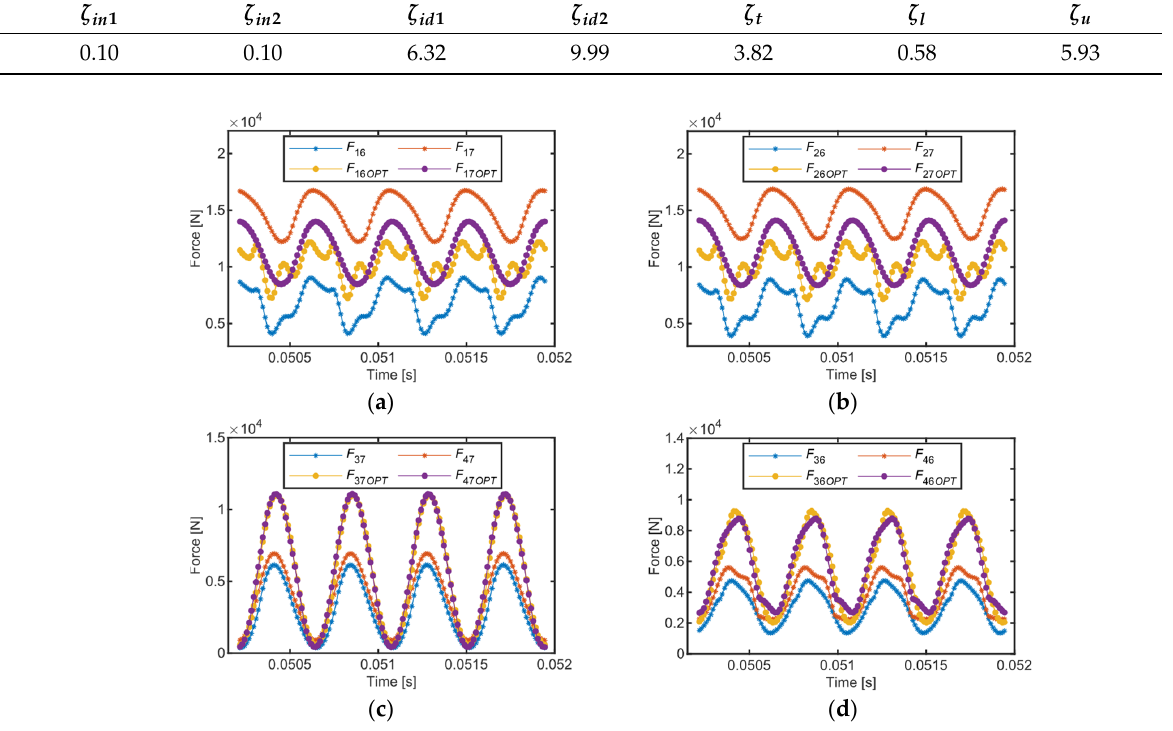
Table 4. Values of optimized support stiffness coefficients.